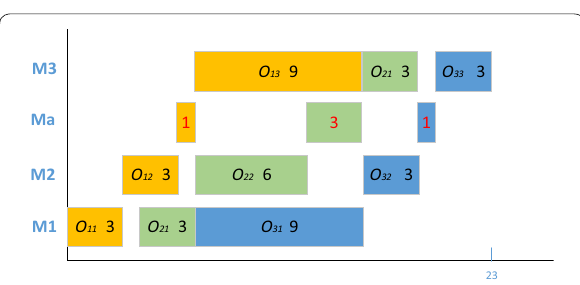
Figure 5 Gantt chart of increasing the number of total machines